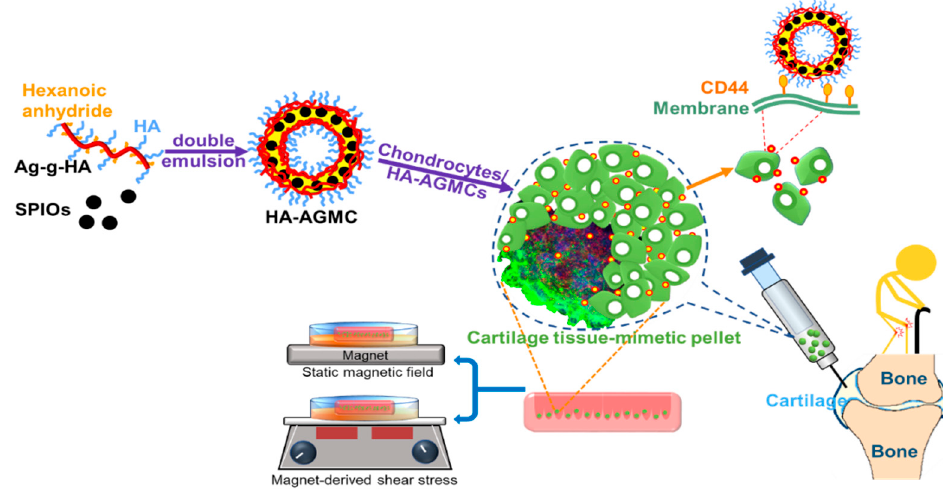
Figure 1. Synthesis of the hyaluronic acid-graft-amphiphilic gelatin microcapsules (HA-AGMCs) structure to fabricate cartilage tissue-mimetic pellets with combined biochemical and biophysical treatments.